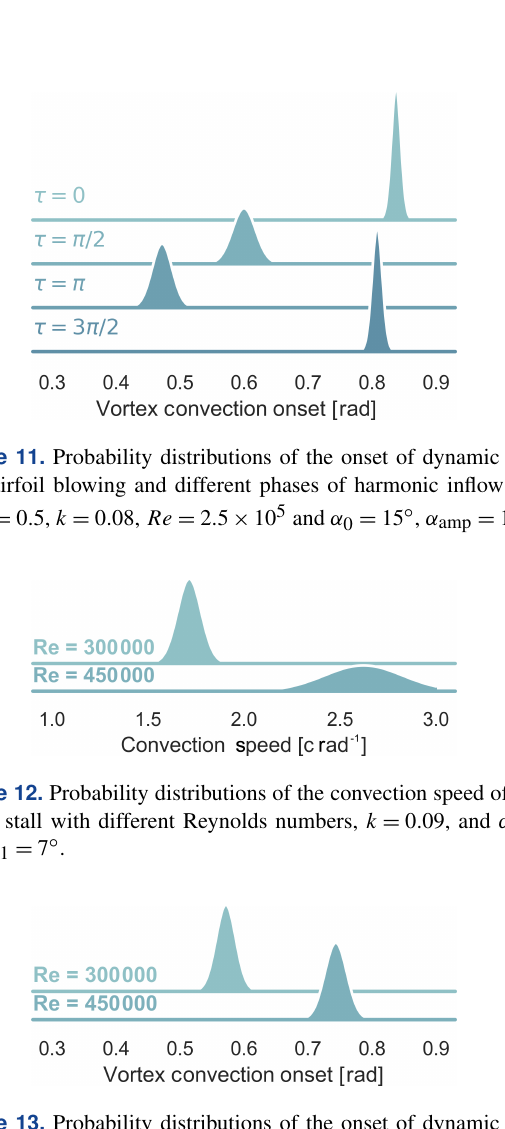
Figure 13. Probability distributions of the onset of dynamic stall with different Reynolds numbers, k = 0 . 09, and α 0 = 18 ◦ , α 1 = 7 ◦